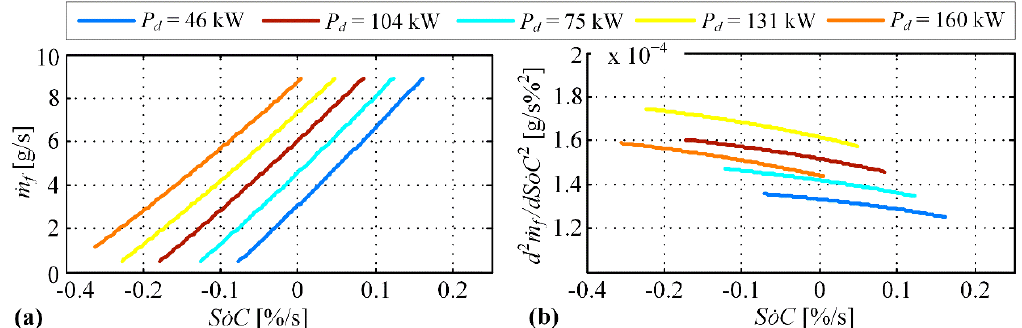
. . . m f versus SoC depletion rate SoC ( a ), and second derivative of m f Figure 9. Fuel consumption rate Figure 9. Fuel consumption rate 𝑚̇ 𝑓 versus SoC depletion rate 𝑆𝑜𝐶̇ ( a ), and second derivative of . SoC curve ( b ), given for several values of demanded power P d , engine speed ω e = 184 rad / s versus 𝑚̇ 𝑓 versus 𝑆𝑜𝐶̇ curve ( b ), given for several values of demanded power 𝑃 𝑑 , engine speed 𝜔 𝑒 = 184 World Electric Vehicle Journal 2019 , 10 , x FOR PEER REVIEW 12 of 15 and SoC = 50%. rad/s and 𝑆𝑜𝐶 = 50%.